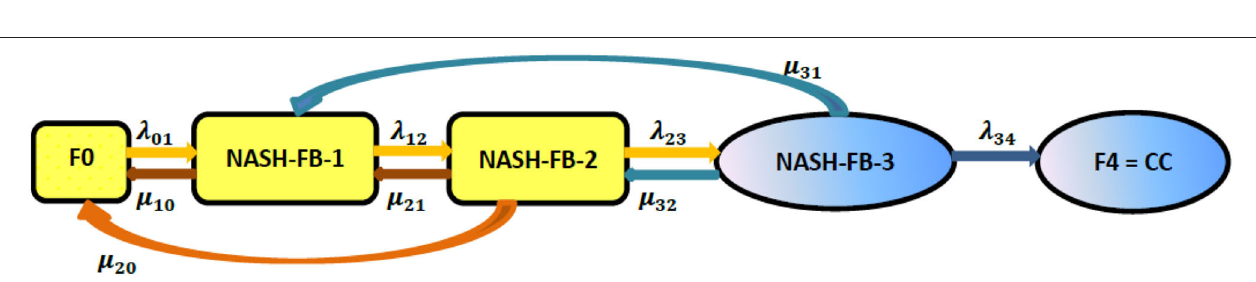
FIGURE 2 | Disease model structure [2]. NAFL-NO FB, non-alcoholic fatty liver with no fibrosis (stage 1); NASH-NO FB, non-alcoholic steatohepatitis with no fibrosis (stage 2); NASH-FB, non-alcoholic steatohepatitis with fibrosis (stage 3); CC, compensated cirrhosis (stage 4); DCC, de-compensated cirrhosis (stage 5); LT, liver transplant (stage 6); PLT, post-liver transplant (stage 7); HCC, hepatocellular carcinoma (stage 8); EM, extramortality (stage 9).